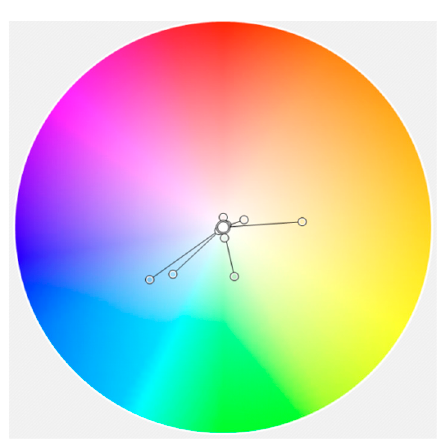
Figure 4. The Google map color analysis.